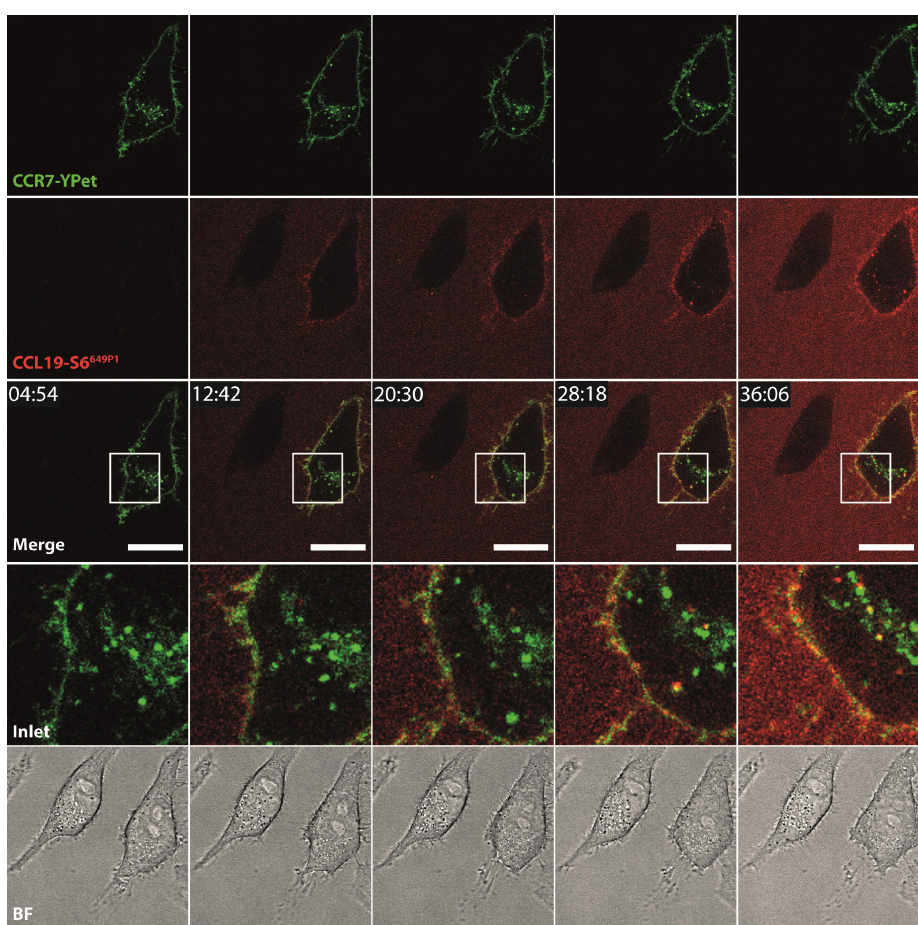
Figure 5. CCL19-S6 649P1 binds to and is internalized specifically by CCR7-expressing cells. Time- lapse confocal video microscopy of HeLa cells transiently expressing CCR7-YPet stimulated at time point 10 min with 10 nM of CCL19-S6 649P1 at 37 °C. Inlets (white rectangles) in merge images illustrate magnification, BF shows corresponding bright field images. Scale bar: 20 µm. Note that the neighboring cell lacking CCR7-YPet expression does not interact with CCL19-S6 649P1 . Images are representative for two independent experiments.